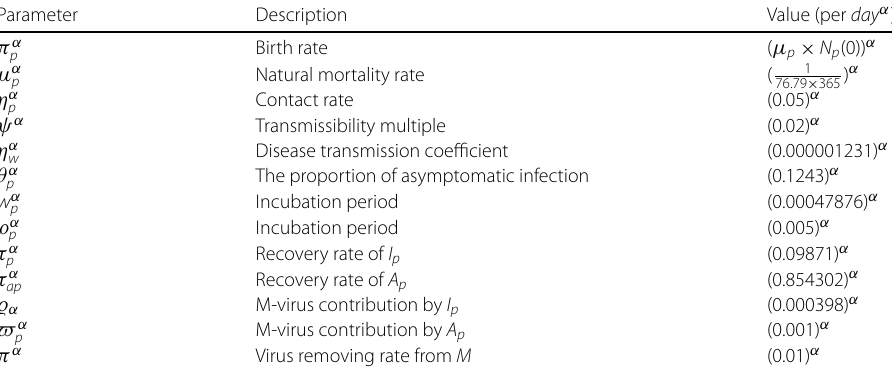
Table 2 The parameter values for COVID model [4] Parameter